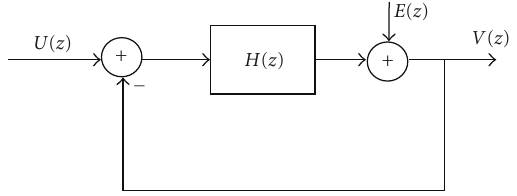
Figure 5: Model of a 1-bit ΣΔ